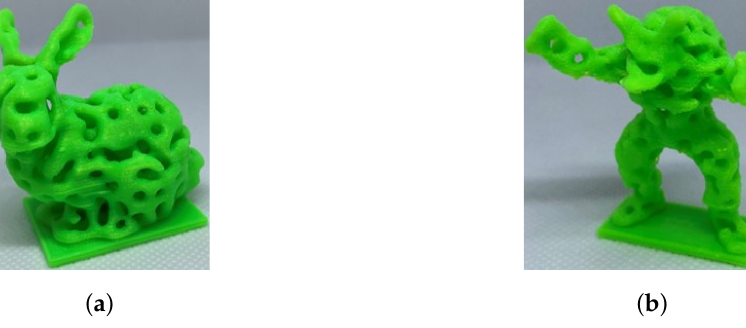
Figure 11. ( a , b ) are 3D printed models of Figures 9c and 10a,